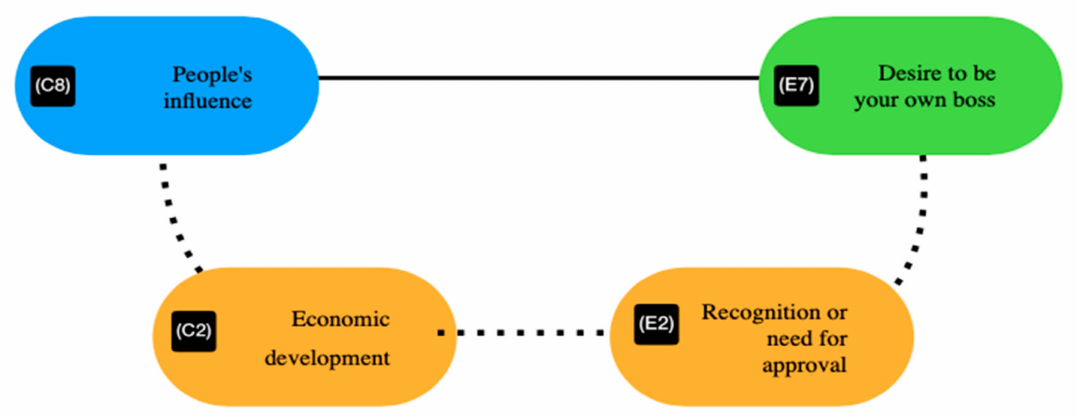
Figure 7. People’s influence and desire to be one’s own boss. Incident C 8 → E 7 . Source: Authors’ elaboration based on fuzzy log.